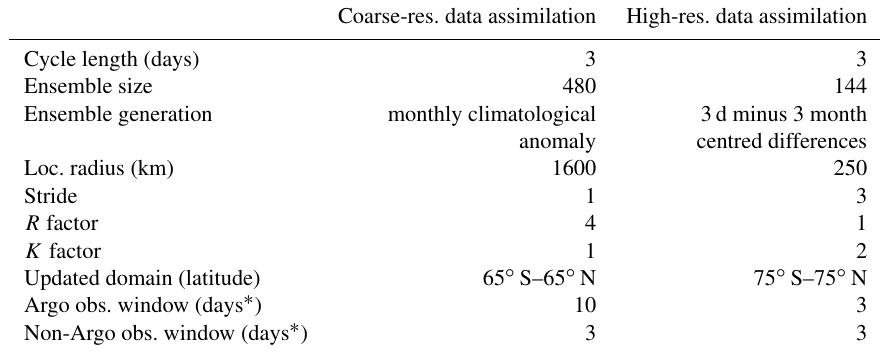
Table A1. Data assimilation parameters at each resolution of the multiscale data assimilation system for BRAN2020. Coarse-res. data